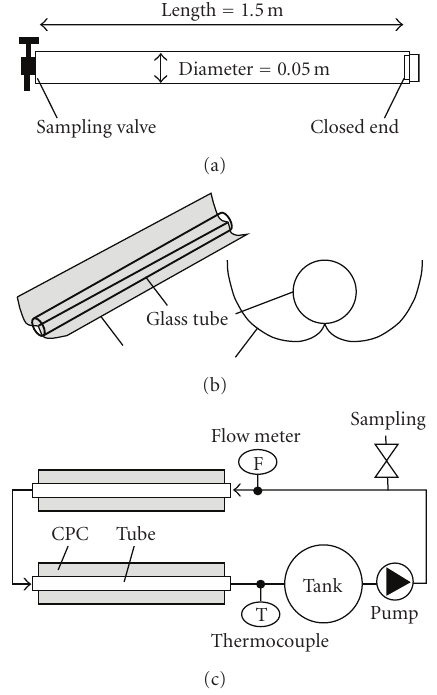
Figure 3: (a) Glass tube configuration. (b) Tube with CPC collector configuration. (c) Flow diagram of the solar CPC reactor (with permission from